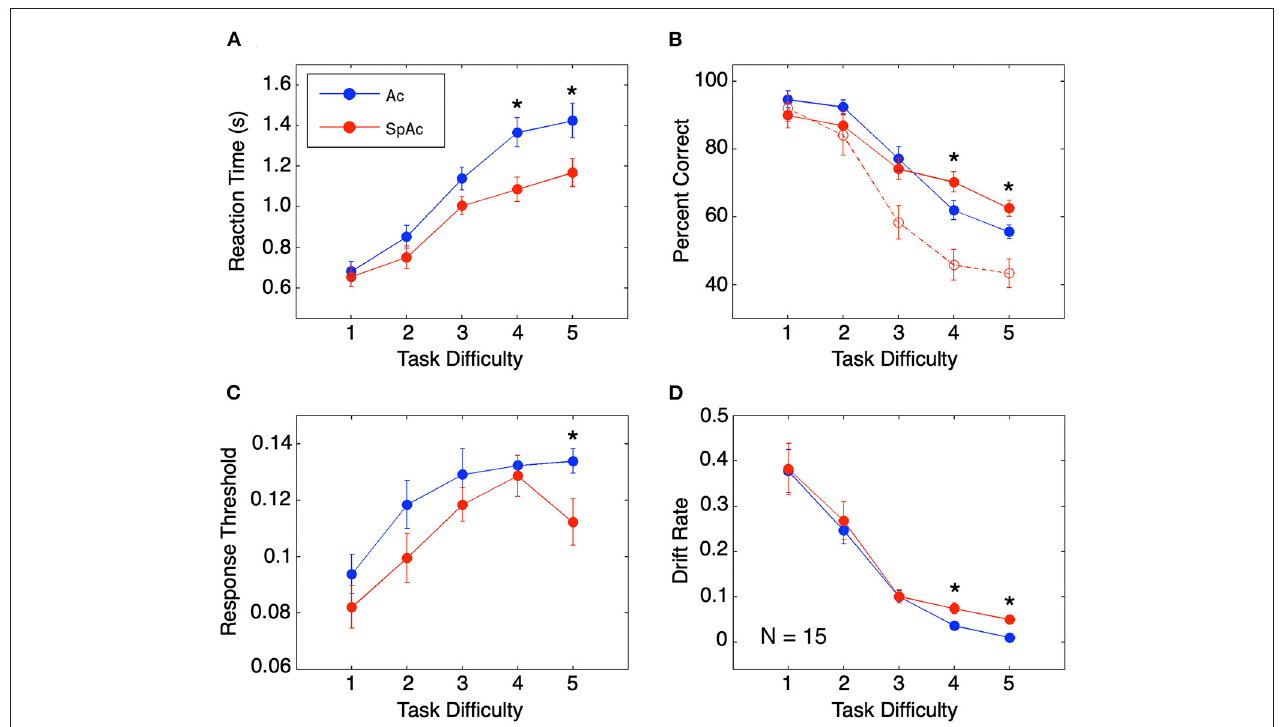
FIGURE 3 | Behavioral performance and model fit. (A) Behavioral response time. Response times are longer for higher task difficulties but shorter with SpAc emphasis ( P < 0.01). (B) Behavioral accuracy measured by percent correct. Accuracy declined with increasing task difficulty. On trials of difficulty levels 4 and 5, when subjects had the full 3 seconds of stimuli, accuracy improved with SpAc emphasis (solid red) relative to with Ac emphasis (blue) ( P < 0.01). Including trials with shorter stimulus durations resulted in reduction of accuracy with SpAc emphasis (dashed red) as reported in prior studies. (C) Response threshold. Response thresholds increased with task difficulty but were lower with SpAc emphasis, ( P < 0.05). (D) Drift rate. Drift rate decreased with task difficulty, but increased with SpAc emphasis for difficulty levels 4 and 5 ( P < 0.01). Error bars are SEM across subjects. Asterisks indicate which SpAc–Ac pairwise comparisons are statistically significant ( P <